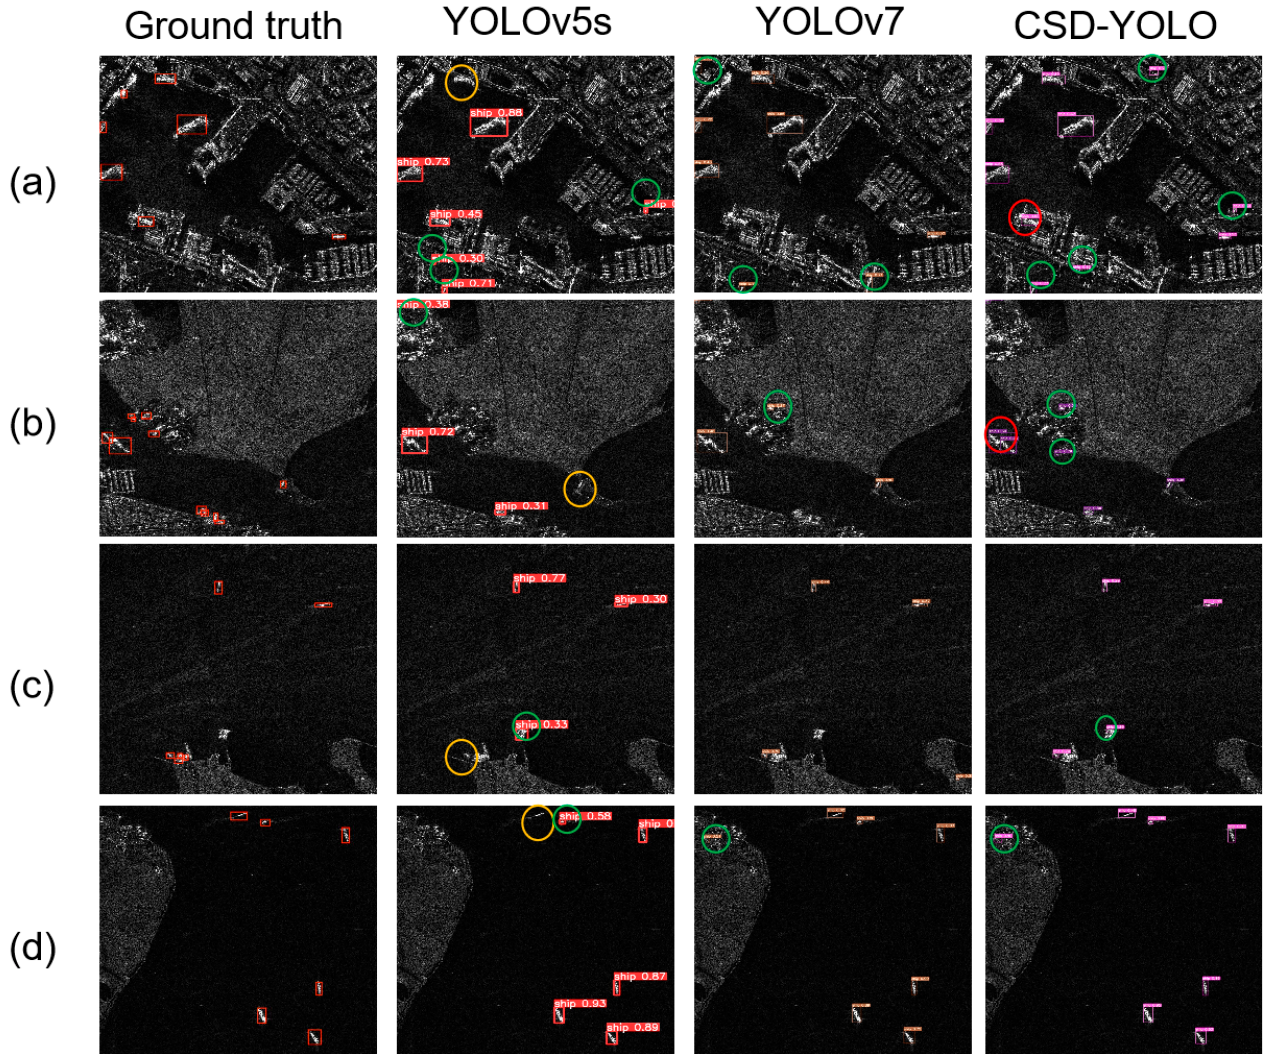
Figure 11. Comparison of the results of YOLOv5S, YOLOv7, and CSD-YOLO. The green circles are the wrong detection of each model; the red circles are the ship detected by CSD-YOLO but not detected by other models; the yellow circles are the target not identified by only one model.